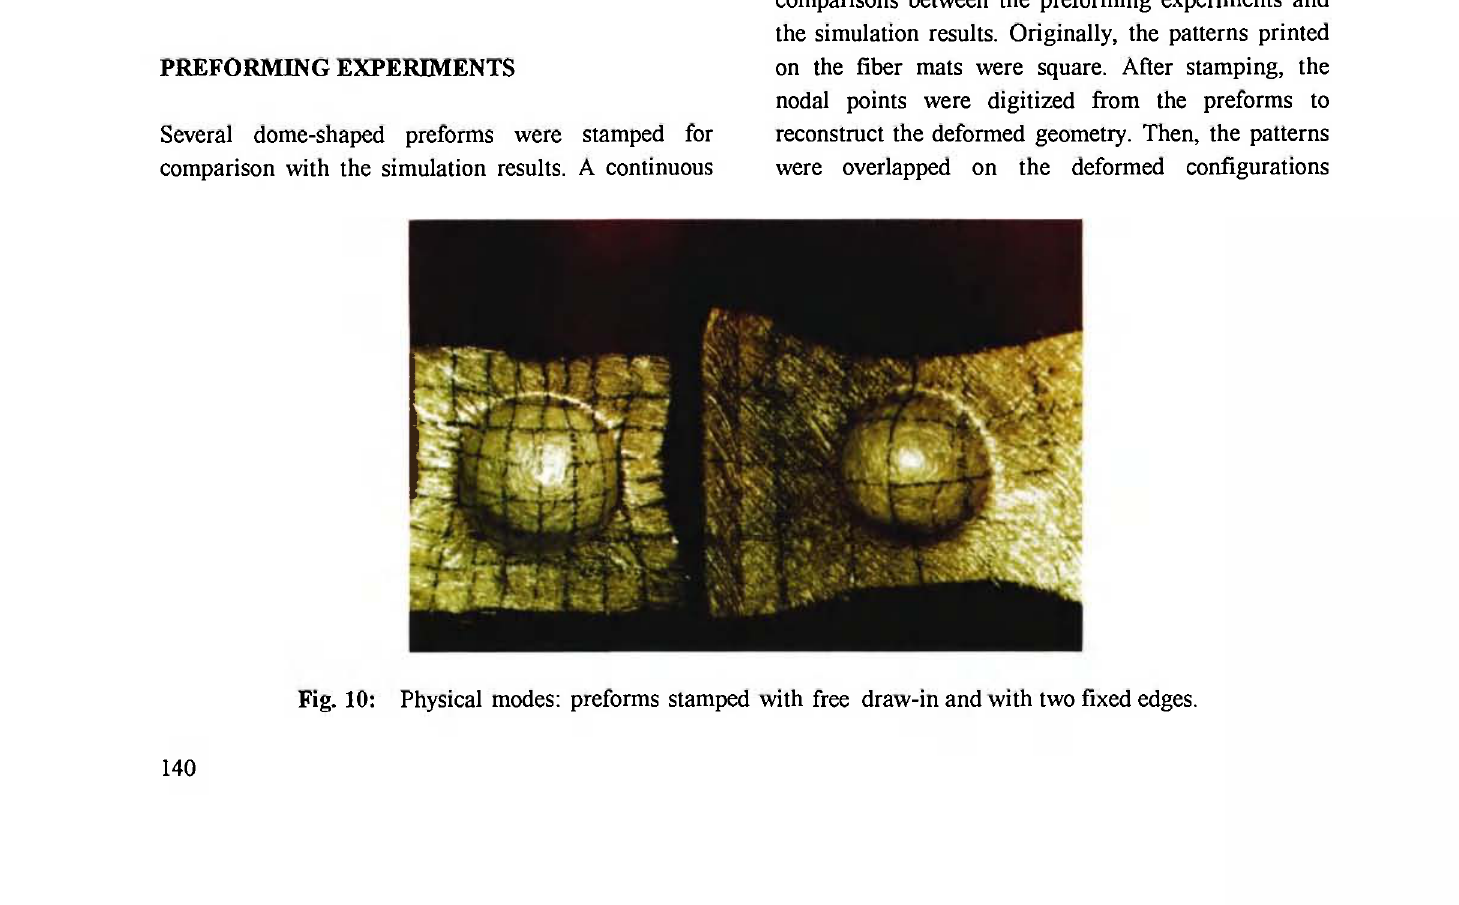
Fig. 9: Fiber content distribution with clamped edges.